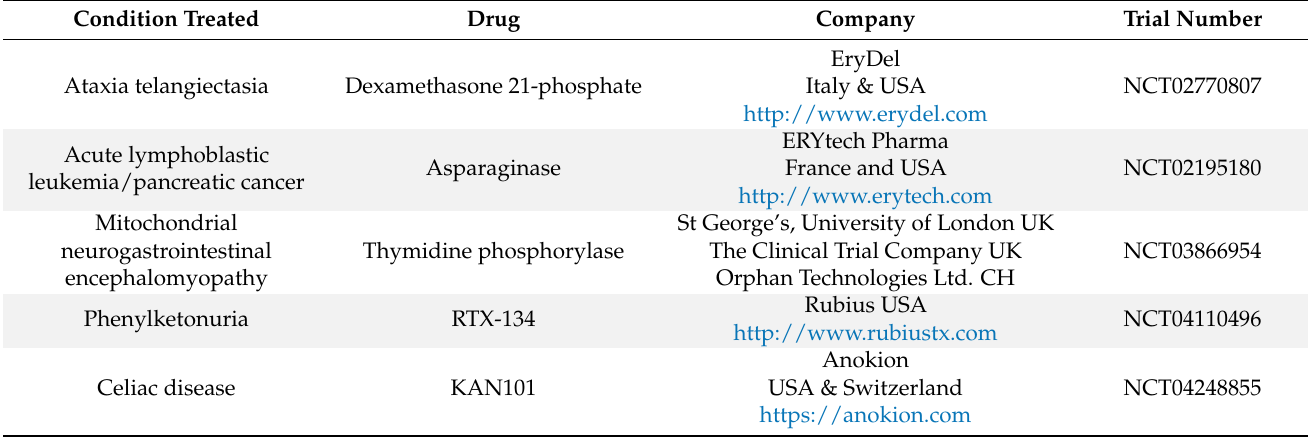
Table 2. Erythrocyte-based formulations in clinical trials. All URLs were accessed in 10 May 2021. Condition